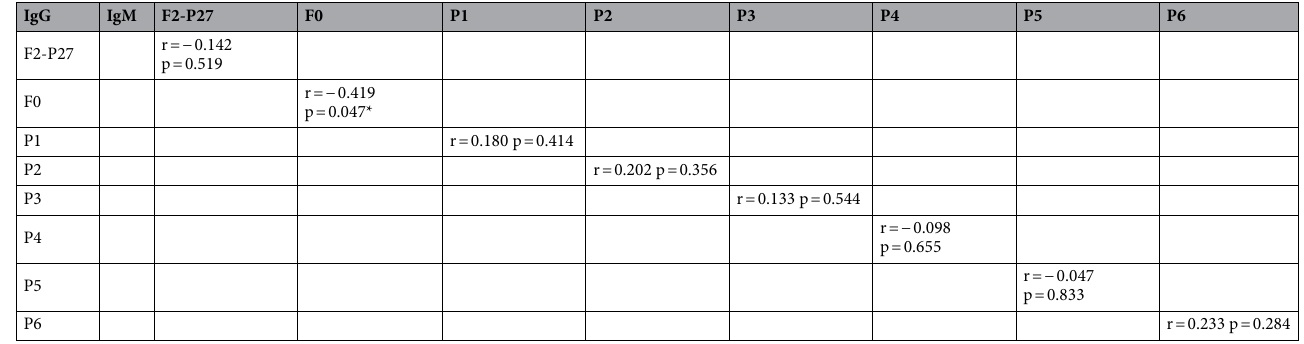
Table 2. Correlations between IgG and IgM levels to F2-P27, F0 and F2-derived peptides. Spearman correlation r; *p values less than 0.05 were considered as significant.